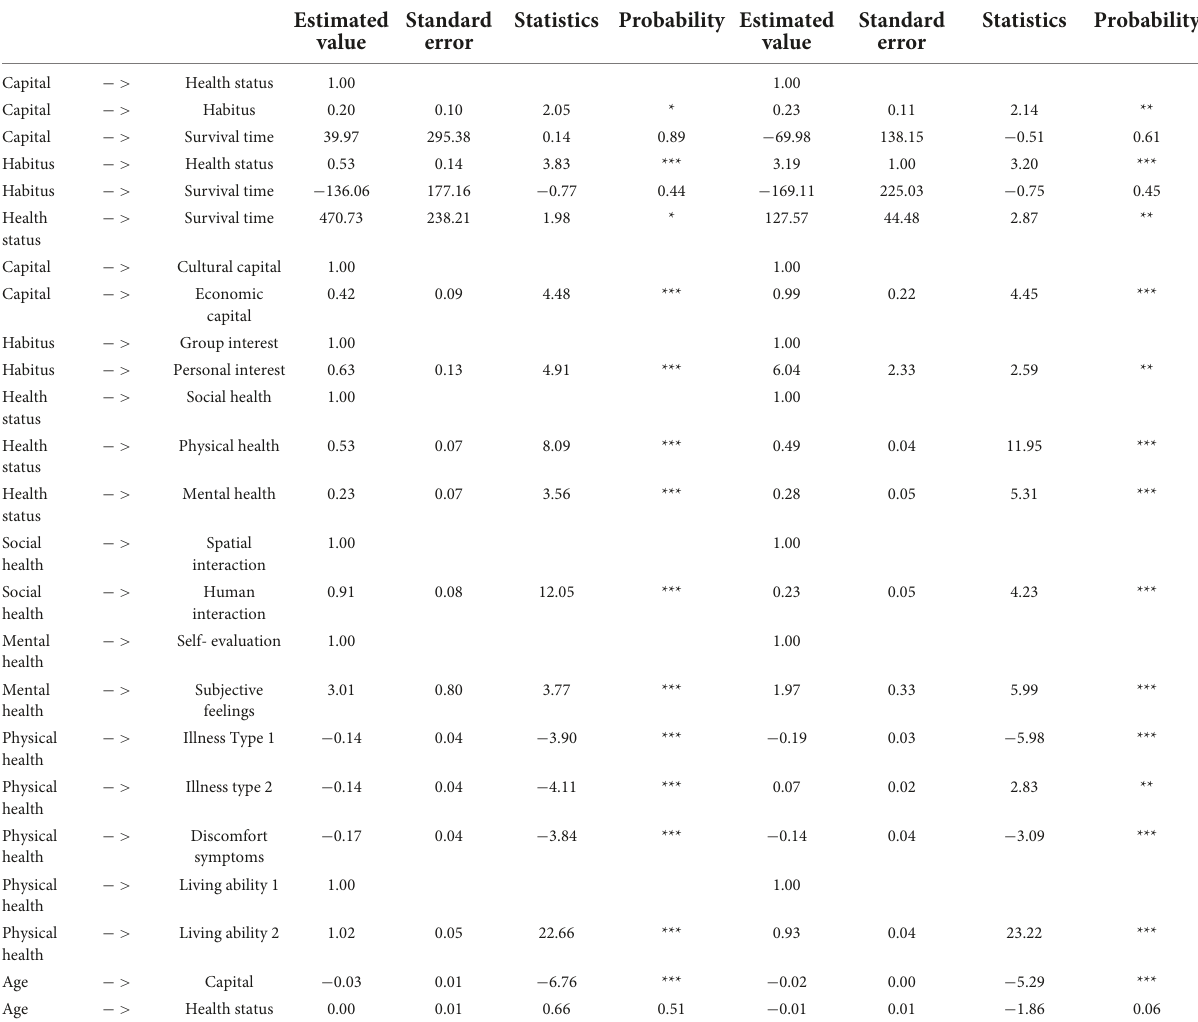
TABLE 2 Non-standardized path coefficients and tests of structural equations of capital, habitus, and